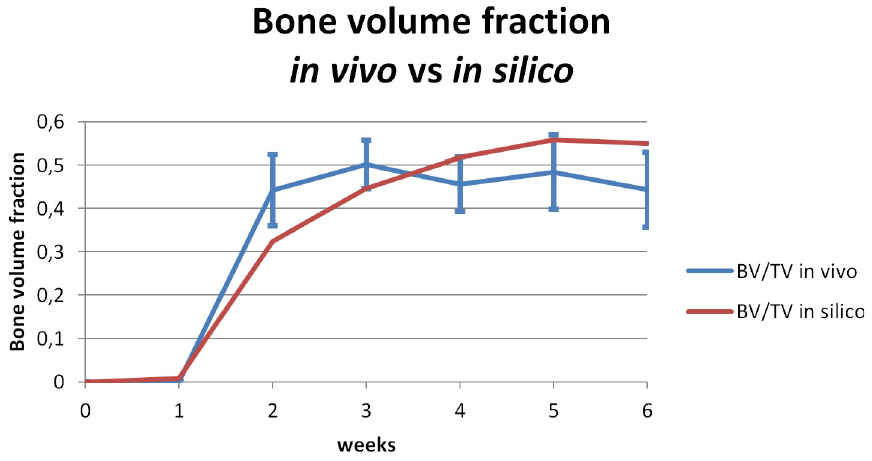
Fig 6. In silico results for a small gap ( 2mm ). The evolution of callus shape and bone tissue filling the callus and gap